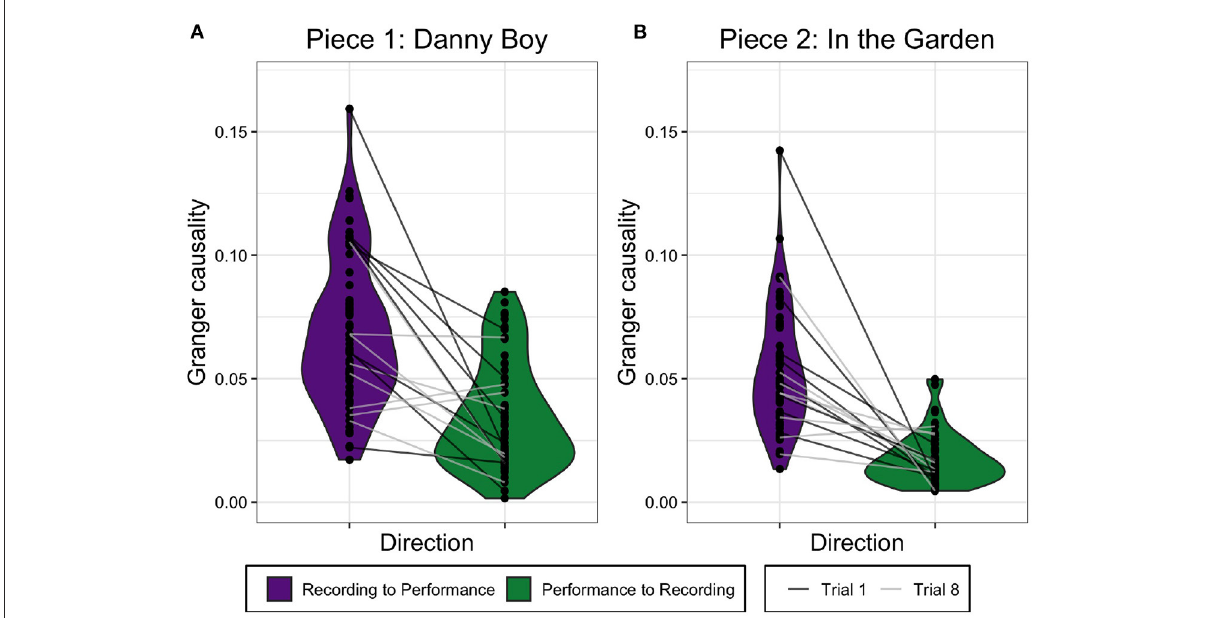
FIGURE2 Granger causality values for both directions, recording to performance and performance to recording, for Danny Boy (A) and In The Garden (B) . The lines show how each participant’s GC values changed between the two directions for Trial 1 and Trial 8.